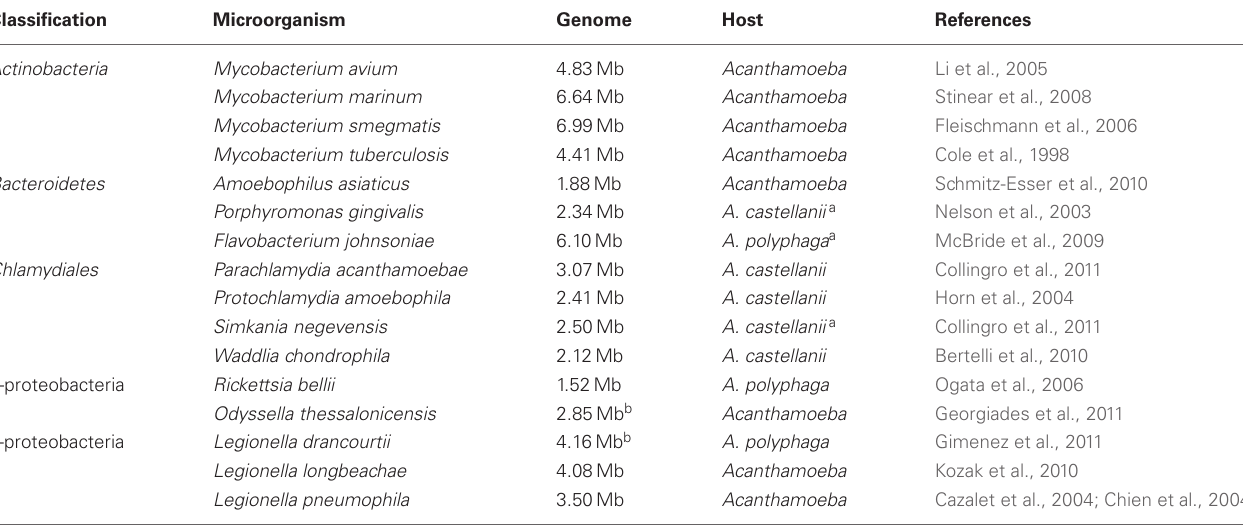
Table 2 | Selected amoeba-resisting bacteria with a publicly available genome